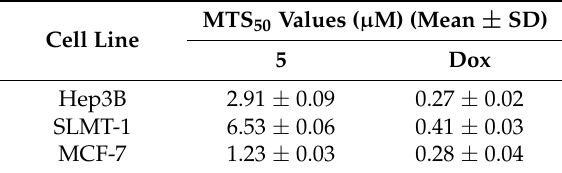
Table 3. Cytotoxicity of compound 5 against three human carcinoma cell lines † .